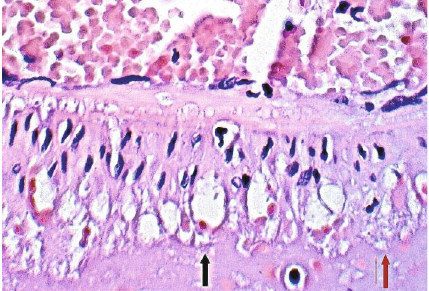
Figure 3: Segmental arterial mediolysis injurious phase. Initial phase of mediolysis. The black arrow points to large, and the red arrow to smaller cytoplasmic vacuoles containing nonstaining clear contents (water) distributed in the outer medial muscle. Hematoxylin & eosin × 400 (adapted with permission from Veterinary Pathology 52(6), copyright 2015, Sage Publications